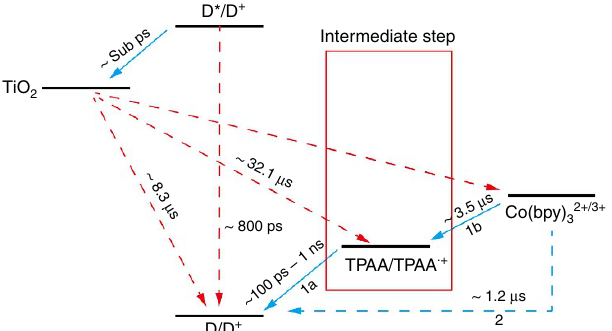
Figure 6 | Overall charge transfer scheme. Charge transfer schemes for the DSSCs fabricated with TPAA/Co electrolyte (path 1) and Co electrolyte (path 2). Regeneration and recombination time constants were summarized from both nanosecond and femtosecond measurements. The injection time was estimated from the fs measurement shown in Supplementary Fig. 4 and Supplementary Table 3.